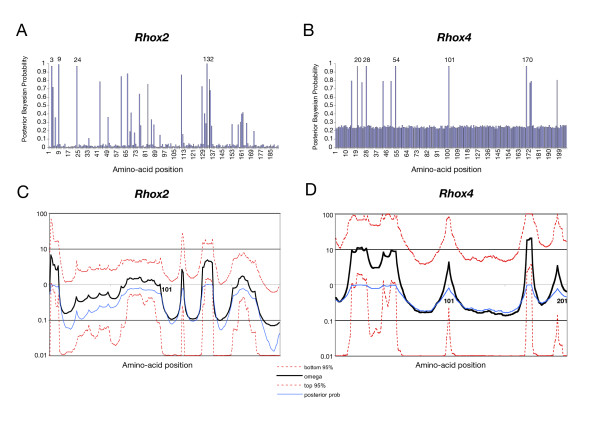
A & B. Posterior Probability of site classes along the Rhox2 (A) and Rhox4 (B) coding aligments. Model M2 is used. Only probabilities of w2 are shown. Sites with a posterior probability higher than 0.95 are considered as having dN/dS ratios significantly greater than 1. C & D. Variation in ω across the Rhox2 (C) and Rhox4 (D) genes was modelled using Omegamap 17. We averaged over the number and position of the blocks using reversible-jump MCMC to obtain the posterior distribution of the omega. The dotted lines are the top and bottom 95% of the estimates of ω from 500,000 iterations. The black line is ω per codon smoothed over blocks of undefined size. Posterior probabilities of >0.95 (blue line) likely indicate significant ω or positive selection. The location of the largest ω values coincide with similar locations as shown in Figure 4A & B obtained from PAML analyses (see text).